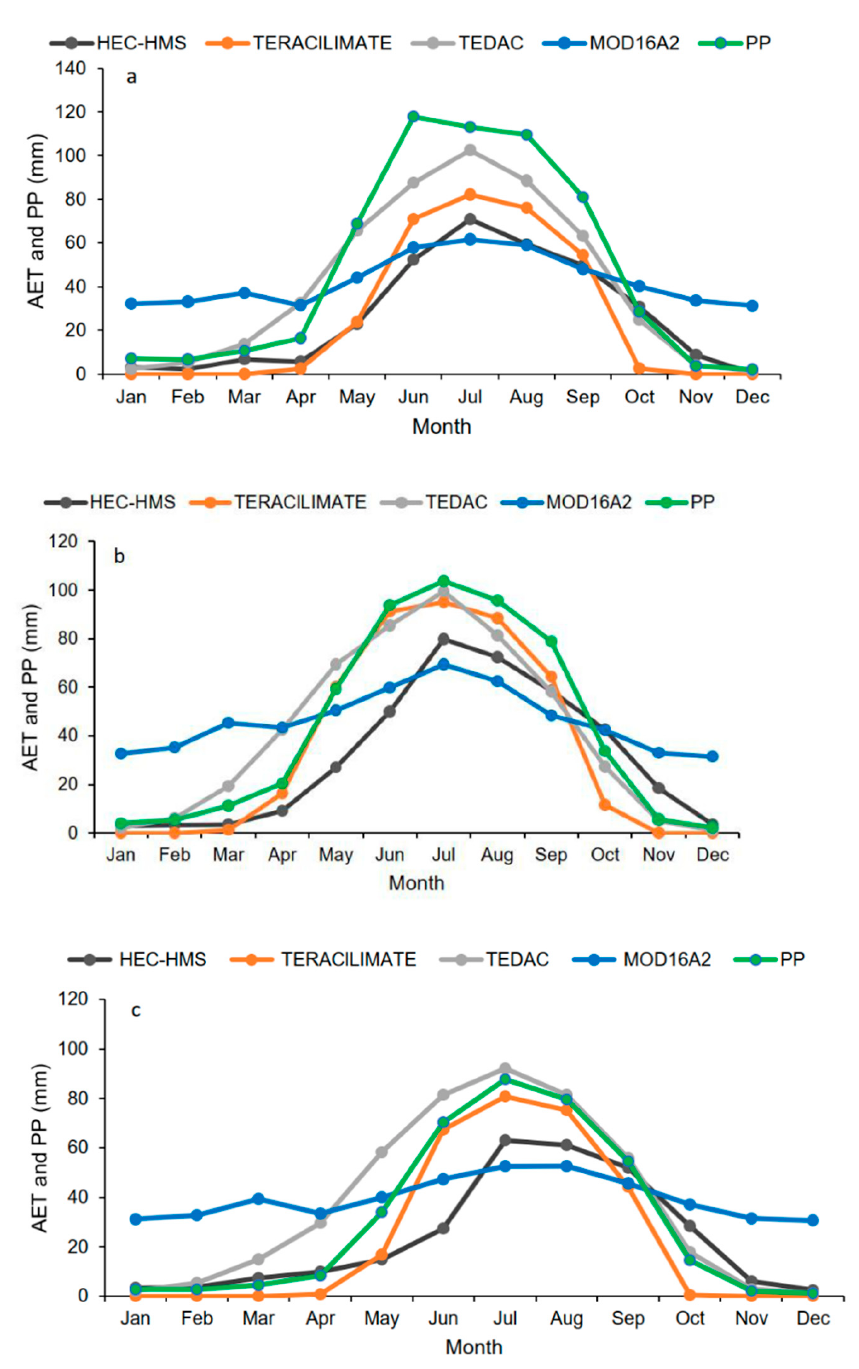
Figure 13. Comparison of AET with TERACLIMATE, TEDAC, and MOD16A2 data in ( a ) the SLR, ( b ) SYER, and ( c ) SYAR. ( b ) SYER, and ( c )